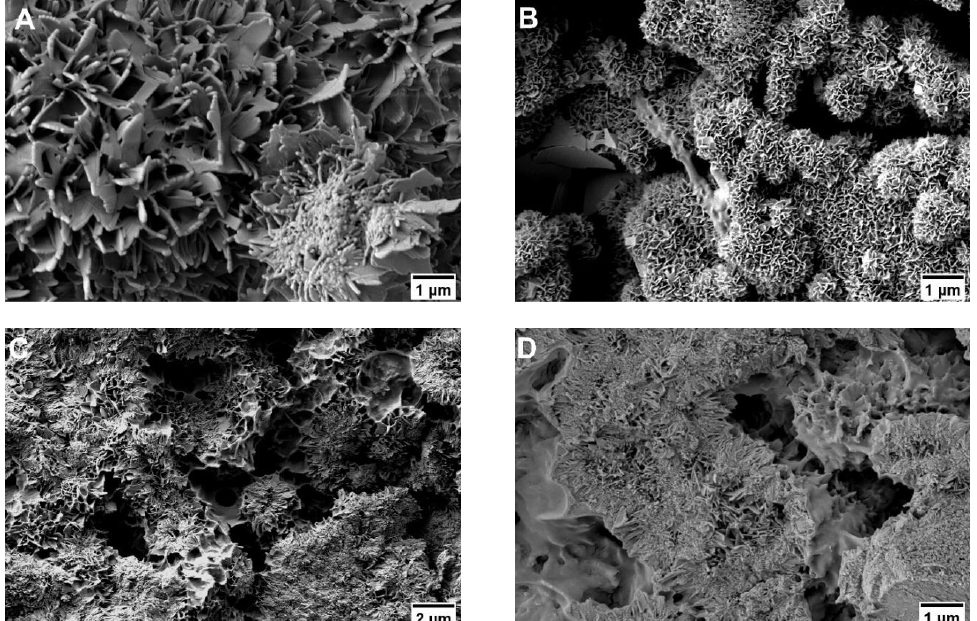
Figure 9. Scanning electron microscopy (SEM) images with different magnifications and details of the samples for surface characterization of HA and the different composite formulations H40, P25 and H40P10 after 8 d of storage. ( A ) Pure inorganic cement matrix showing typical HA needle-like structures (HA); ( B ) Batch with 40 wt% HEMA-addition depicting both, a successful setting and HA-formation as well as gelation (H40); ( C ) Smooth areas covering HA-needles and platelet structures indicating hydrogel formation for the batch containing 25 wt% hydrogel precursor PEG-PLLA-DMA (P25); ( D ) Combination of HEMA (40 wt%) and cross-linker (H40P10) resulted in a successful conversion to HA with an incorporated hydrogel mix of pHEMA and cross-linked PEG-PLLA-based